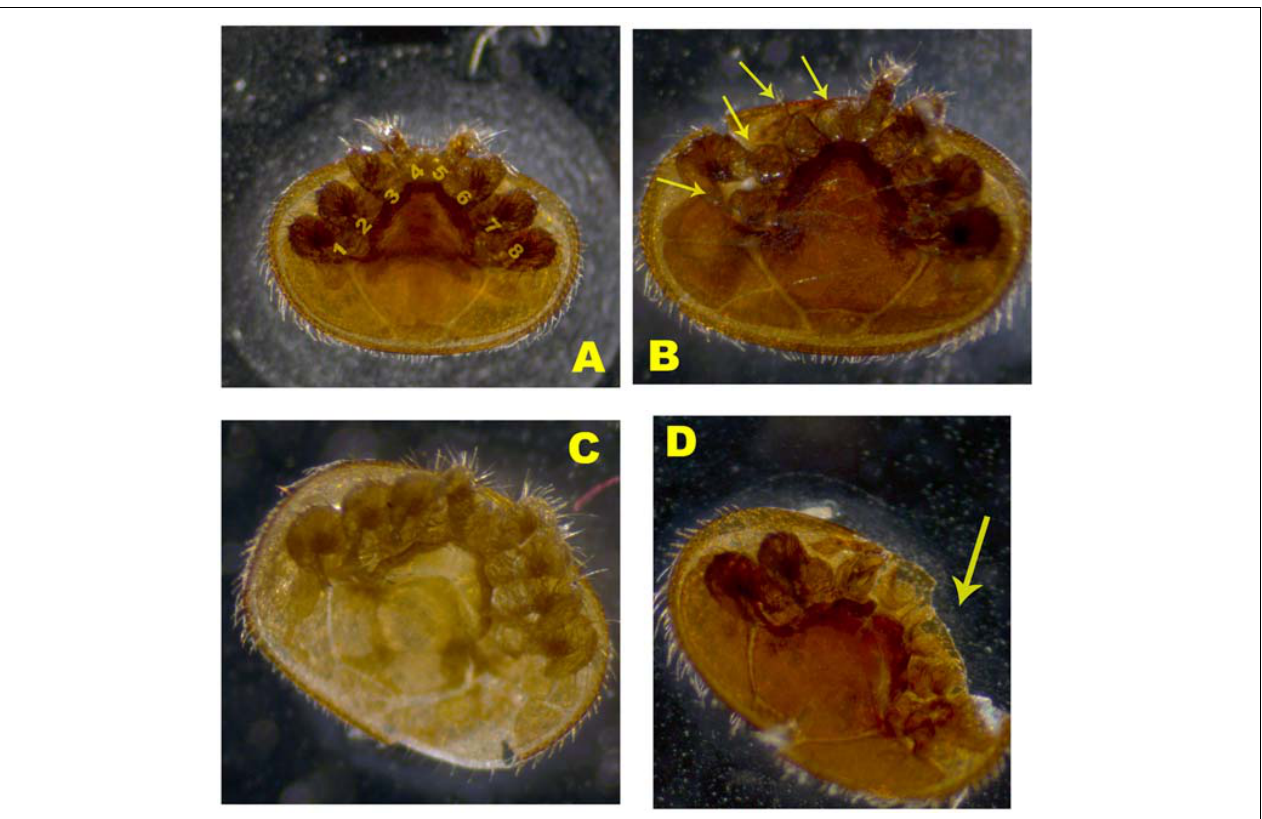
FIGURE 2 | Images of damaged Varroa mites from the sampled colonies. (A) Mature mite with no damage. Label numbers 1–8 indicate the eight legs of the Varroa mite. (B) Damaged mite with legs missing. (C) Young mature mite. (D) Mature mite with a missing body part. Arrows indicate the damaged legs or body